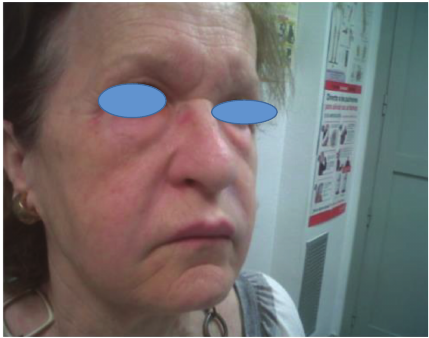
Figure 4: After the immunosuppressive treatment, the patient presented a regression of the